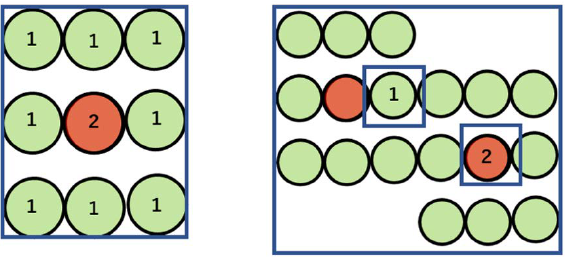
Figure 8. The left panel shows a point at the position for our scoring. If one detects the absorber position, one obtains two points. The right panel shows one example of scoring for two absorbers that leads to three total points, which means the detection probability of 75%.